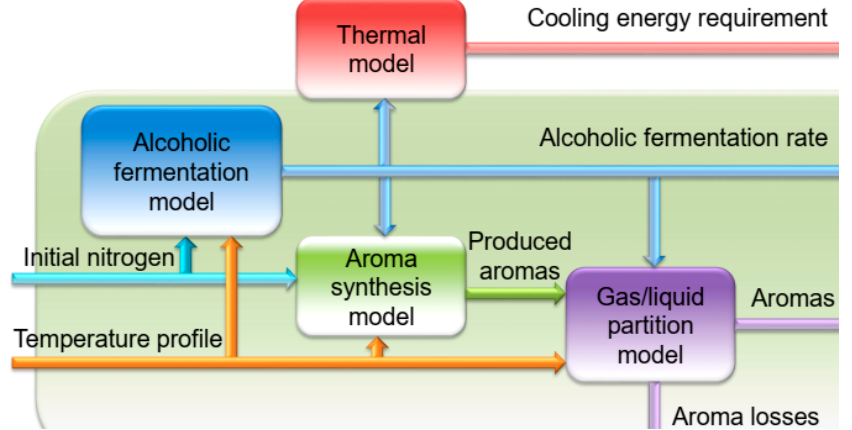
Figure 8. Structure of the global wine fermentation model. The global model integrates four models calculating the fermentation rate, the energy required for temperature regulation, the synthesis of the main fermentation aromas, and the distribution of these aromas between the gas and liquid